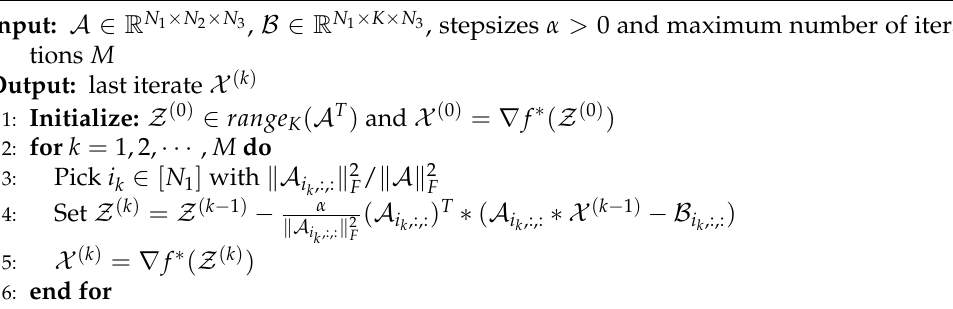
Algorithm 2 Randomized Regularized Kaczmarz